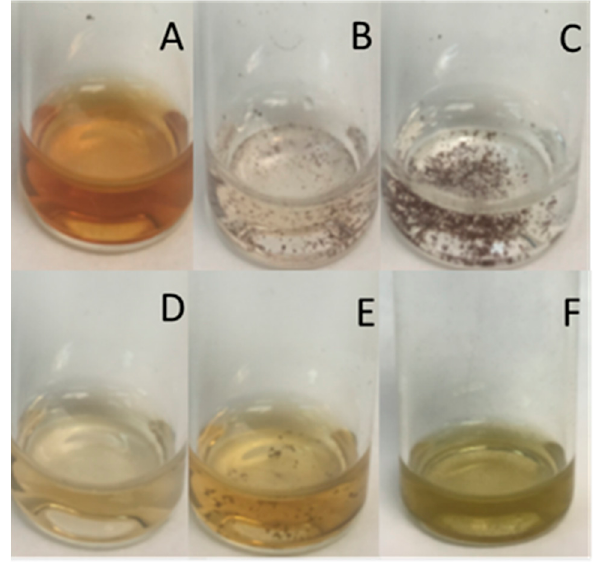
Figure 5. Visual evaluation of AgNP-polymer solutions after 5 h at 90 °C (one month). ( A ) F1Q, ( B ) F2Q, ( C ) F3Q, ( D ) F1L, ( E ) F2L, and ( F ) F3L.